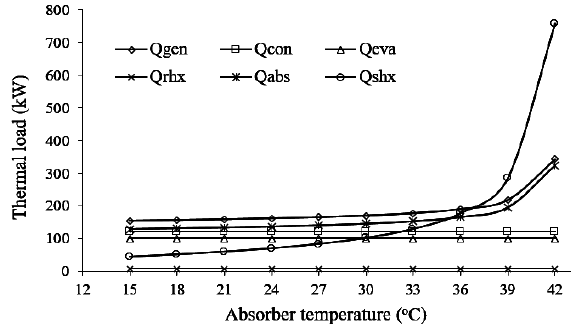
Figure 27. Effect of T abs on the thermal loads.